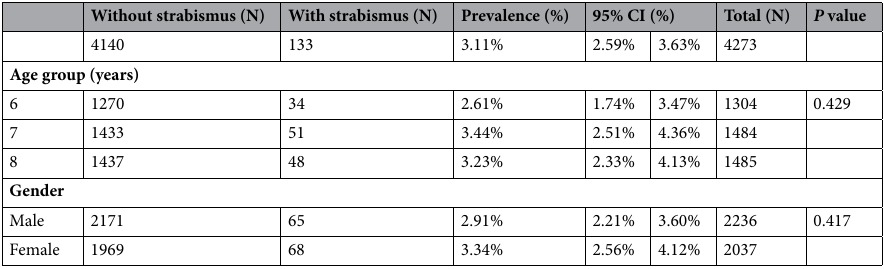
Table 1. Prevalence of strabismus in Hong Kong children by age and gender. CI confidence interval.